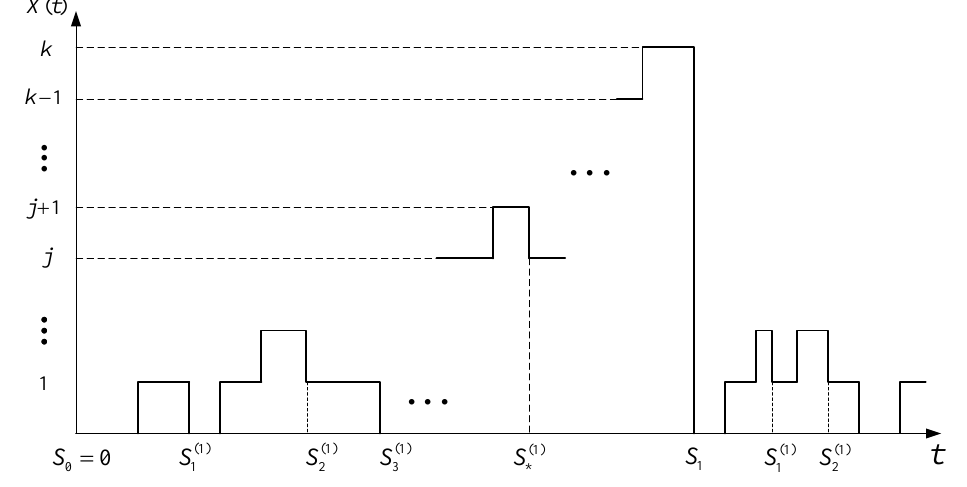
Figure 2. Trajectory of the process X for the system with a full repair